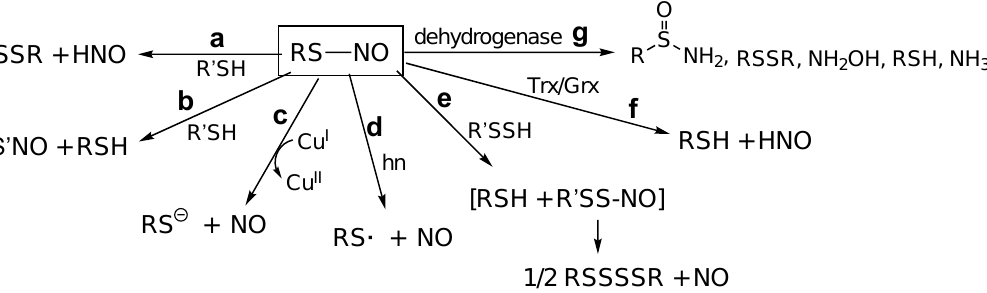
Figure 5. Currently proposed mechanisms for RS-NO degradation. ( a ) S-thiolation and the generation of HNO, ( b ) transnitrosation, transfer of ‘NO + ’ with no generation of NO, ( c ) Cu I -mediated reaction with formation of NO and RSH (not likely to be of general relevance based on current literature), ( d ) photochemical cleavage of the RS-NO bond with formation of NO and highly oxidizing RS · (not of general relevance except maybe in specific situations (e.g., skin)), ( e ) RSSH-mediated destruction of RS-NO with formation of NO and unreactive RSS· (which dimerizes to RSSSSR, which can be reduced to RSH), ( f ) Trx or Grx-mediated reduction of RS-NO to RSH and ultimately to HNO, not NO, ( g ) dehydrogenase-mediated conversion of RS-NO to a variety of possible products without generation of NO, primarily relevant only to GS-NO.